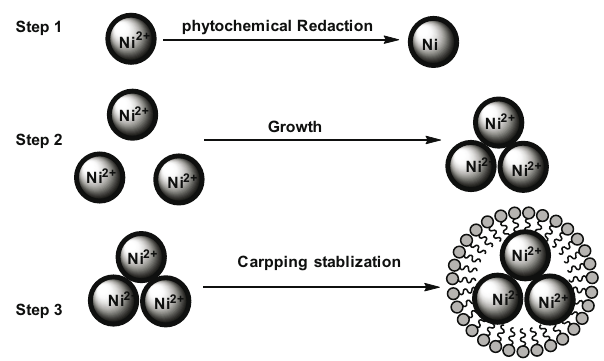
Figure 7: Mechanism of nanoparticle formation.